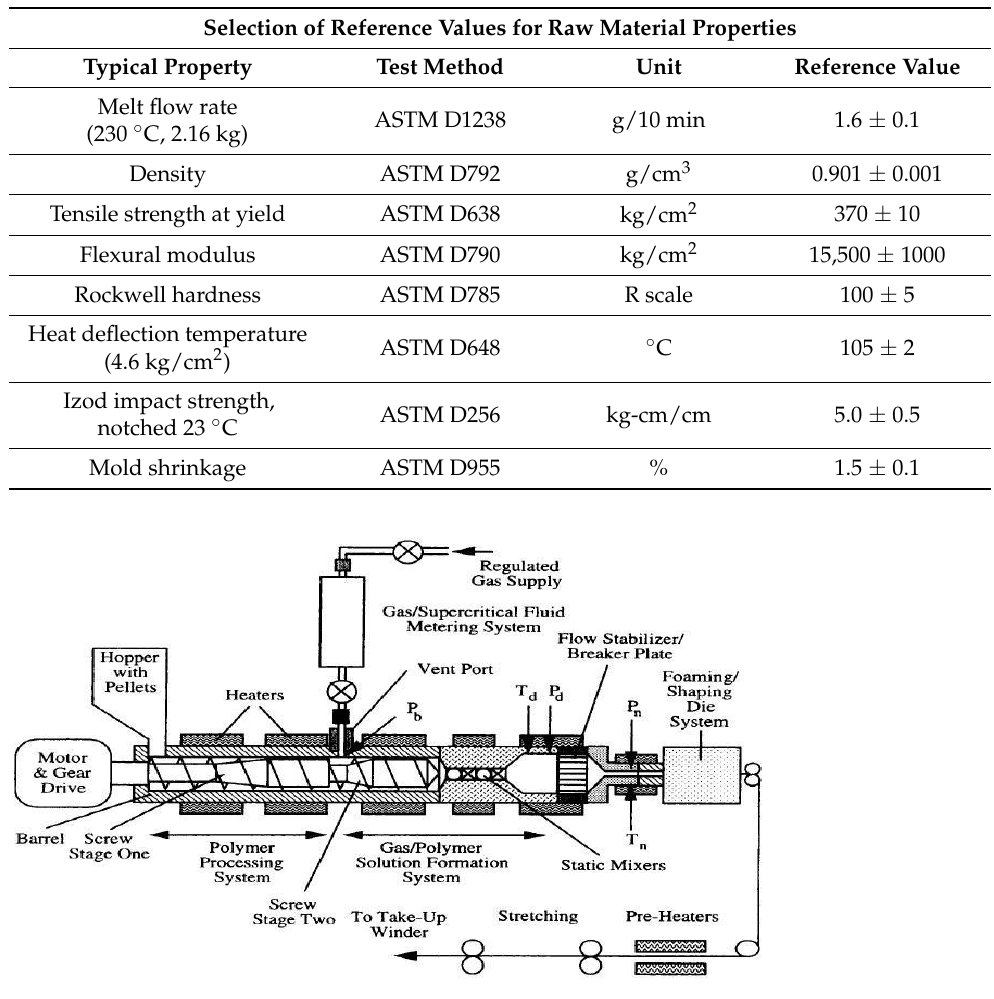
Figure 2. The schematic of polypropylene physical foaming process (Reprinted with permission from Ref. [25]. Copyright 2022, Chen and Lin).